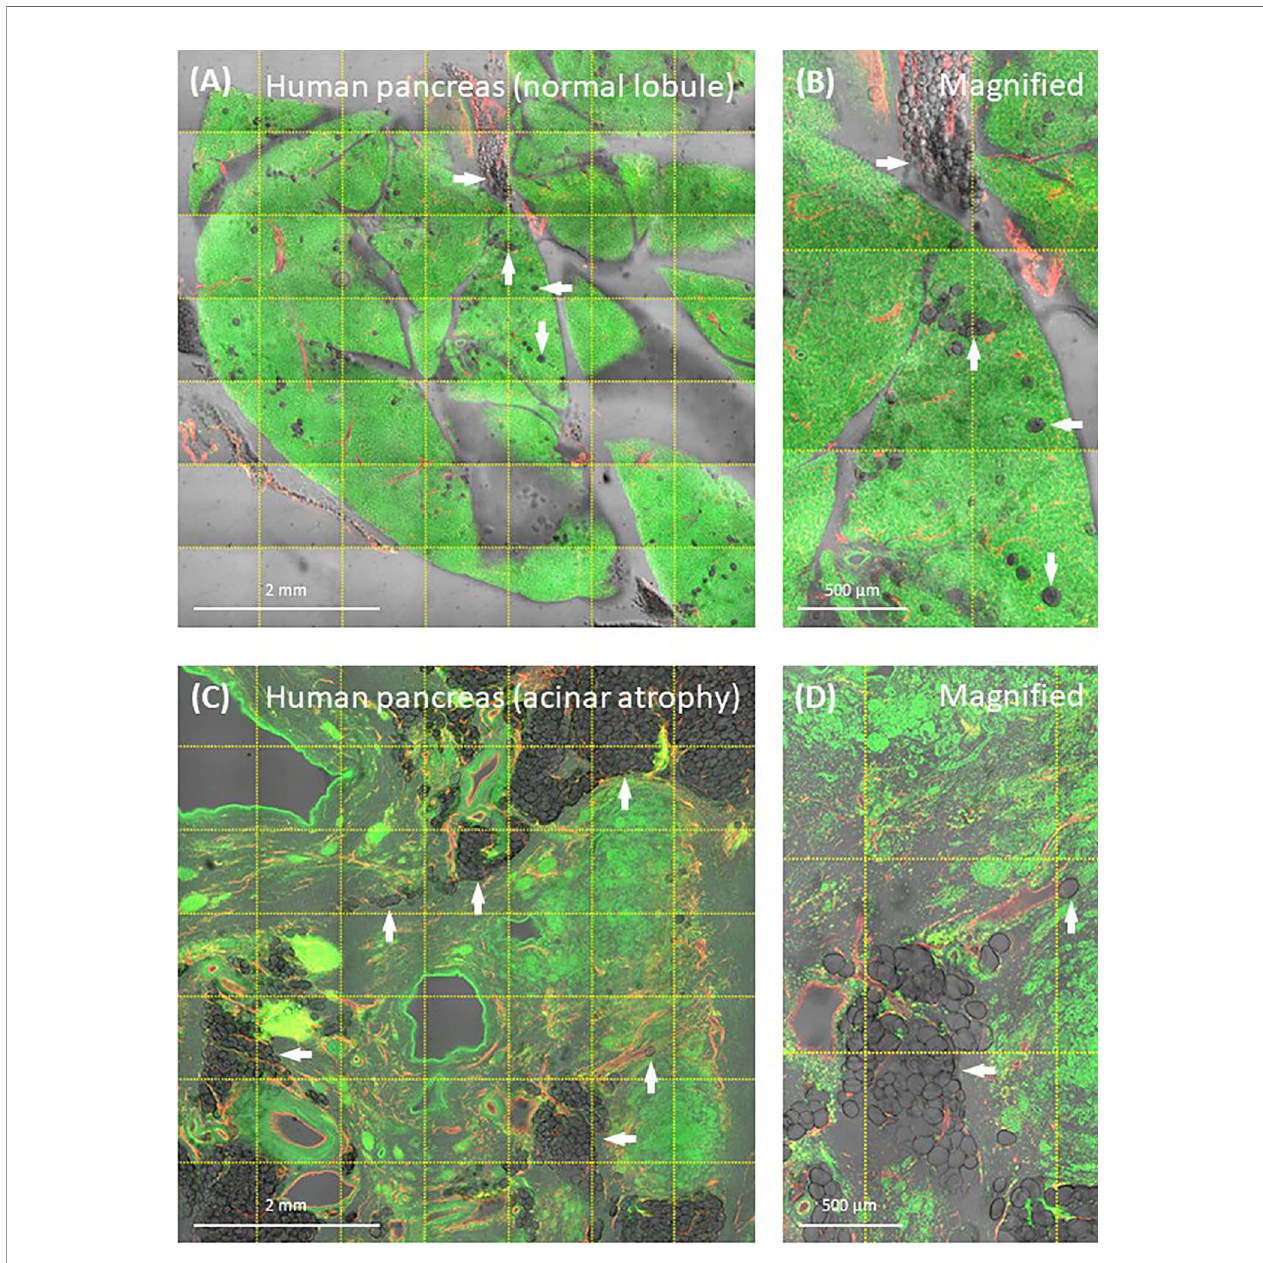
FIGURE 6 | Human pancreatic fatty in fi ltration. Images were derived from tile scanning of optically cleared pancreatic specimens. (A, B) Normal lobule of human pancreas. Adipocytes are clearly seen around the blood vessel and inside the lobule (magni fi ed, arrows). Green, nuclear staining; red, CD31. (C, D) Acinar atrophy of diseased lobule. This view was acquired 2-cm distal to the pancreatic ductal adenocarcinoma. Overlay of transmitted light and fl uorescence signals identi fi es the fatty in fi